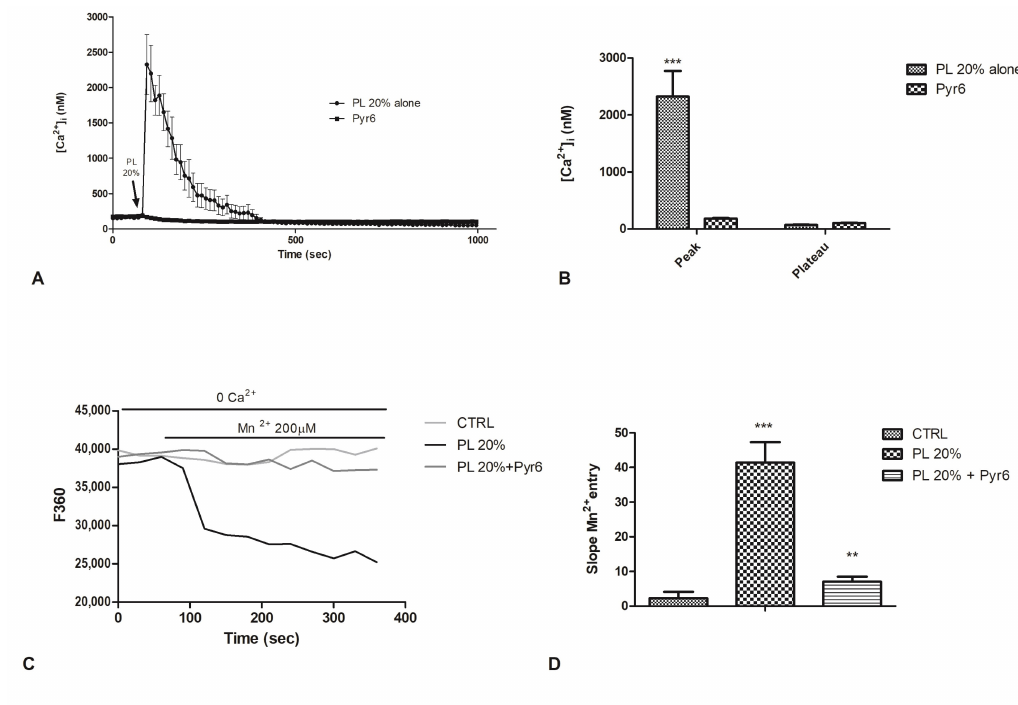
Figure 7. The inhibition of Orai1 channel abolished PL-induced Ca 2 + entry. A. PL-induced Ca 2 + entry was completely abolished in the presence of 1 µ M Pyr6 (30 min preincubation). PL was added at 20% v / v . Data are means ± s.e.m. of [Ca 2 + ] i traces recorded in di ff erent cells. Number of cells: PL alone: 40 cells from 3 experiments; PL + Pyr6 1 µ M: 50 cells from 3 experiments. B . Mean ± s.e.m. of the Ca 2 + response to 20% PL recorded at the peak and at the plateau under the designated treatments. Data are means ± s.e.m. of [Ca 2 + ] i measured by confocal imaging at peak maxima. Number of cells: PL alone: 40 cells from 3 experiments; PL + Pyr6 1 µ M: 50 cells from 3 experiments. Asterisks on bars indicate statistical di ff erences determined by two-way ANOVA with Bonferroni’s correction ( p < 0.001). C. Using the Mn 2 + -quenching technique, the resting Ca 2 + entry in bEND5 cells was evaluated. First, the extracellular medium was replaced with a 0Ca 2 + solution and then, to cause an immediate decay in Fura-2 fluorescence, 200 µ M Mn 2 + was added. PL 20% treatment allowed an evident decay of fluorescence, while pre-incubating the cells with Pyr6 strongly prevented this decay. CTRL indicates cells incubated in 0Ca 2 + solution. D. The quenching rate of Fura-2 fluorescence induced by Mn 2 + addition was calculated as the slope of a linear regression. Di ff erent asterisks on bars indicate statistical di ff erences (*** p < 0.001; ** p <